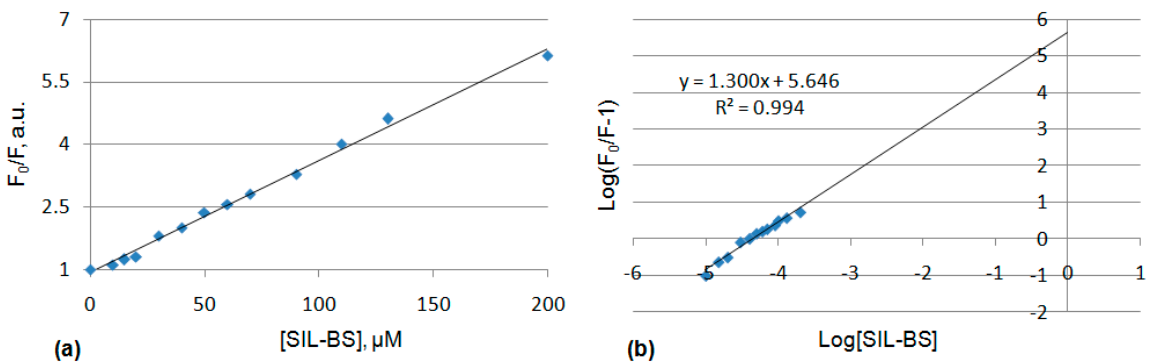
Figure 6. Stern–Volmer plot at λ em = 338 nm obtained from steady-state measurements ( λ exc =280 nm) in PBS pH 7.4 (1% DMSO SIL-BS) ( a ) and the double-log plots of SIL-BS quenching effect on BSA fluorescence ( b ).